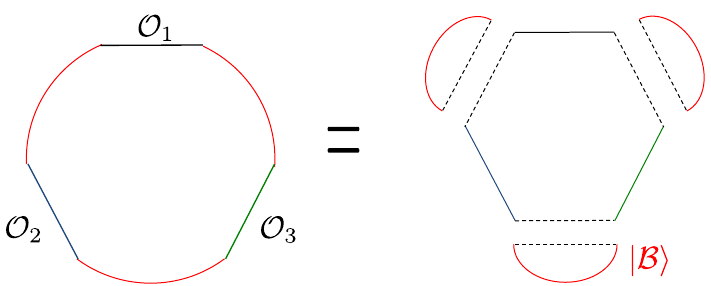
Figure 2 . Hexagonalization of a three-point function on the Wilson loop. The three-point function on the Wilson loop can be decomposed into a single hexagon and three boundary states. To glue the boundary states to the hexagon, we contract the boundary states jBi , which are denoted by red curves and correspond to segments of the Wilson loop, with the